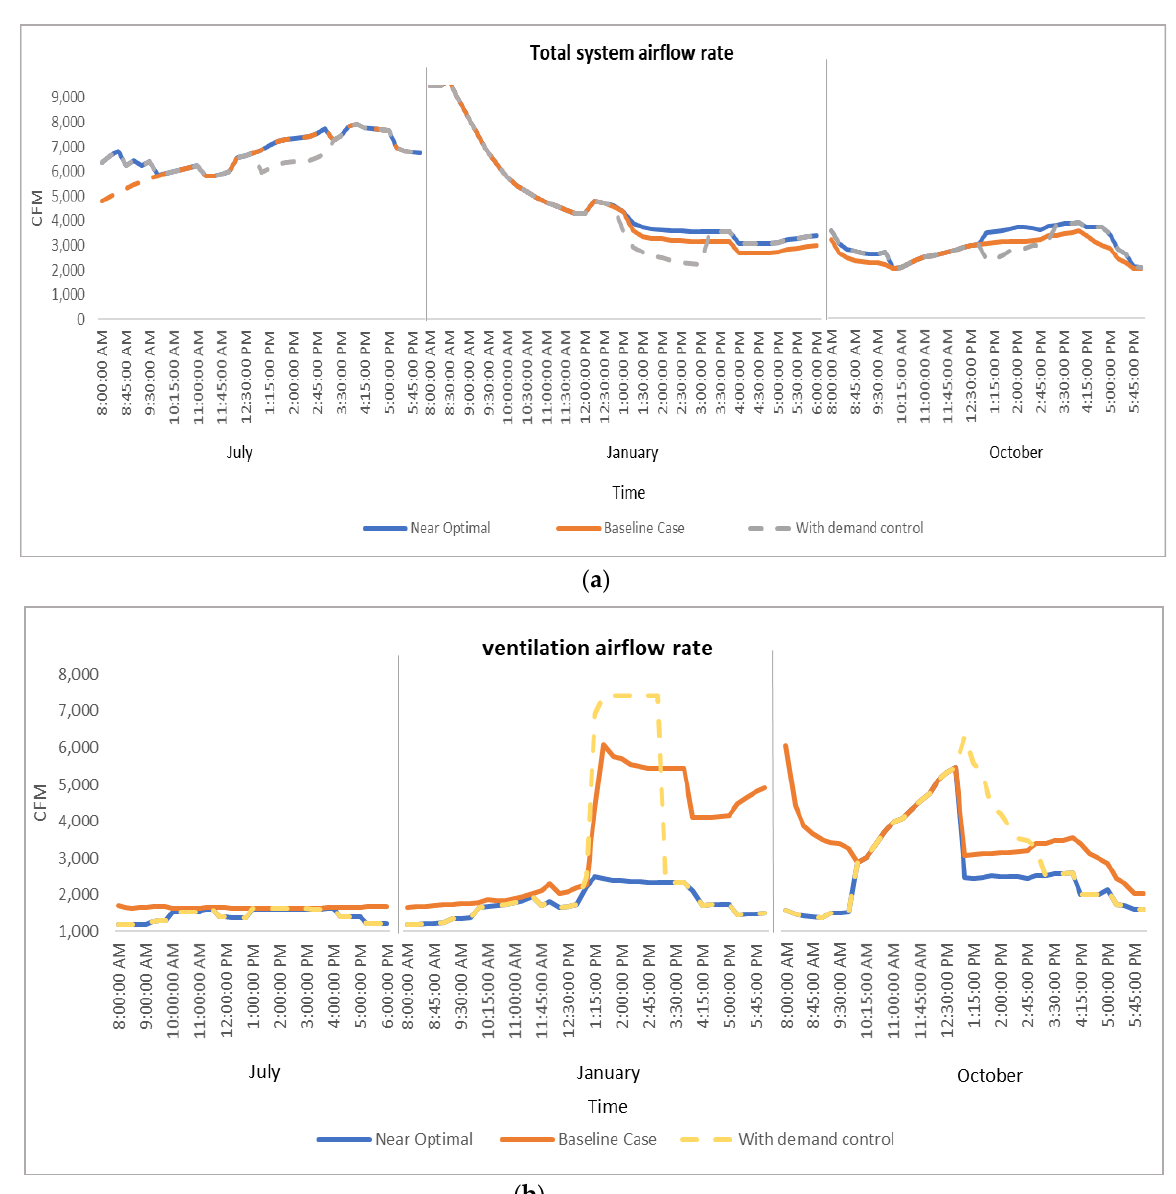
Figure 13. ( a )The total system airflow rate for each day being analyzed. ( b ) The total system airflow rate for each day being analyzed.